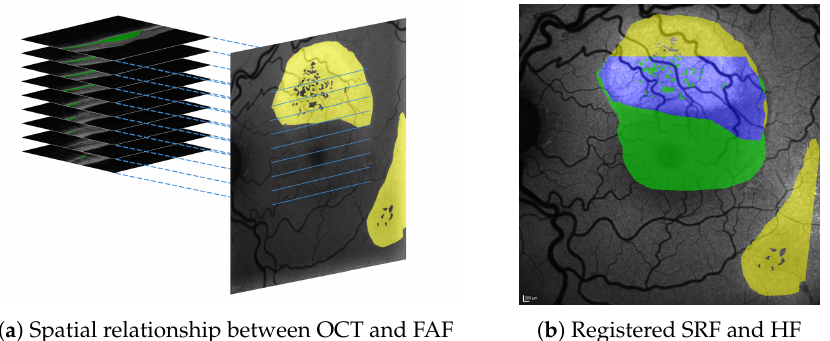
Figure 1. Spatial relationship between SRF (green) in 3D OCT B-scans and HF (yellow) in 2D en face FAF images ( a ), both of which are shown with roughly physically aligned orientations. Our approach allows to precisely register segmentations from both and visualise their overlap (shown in blue), e.g., in FAF image space ( b